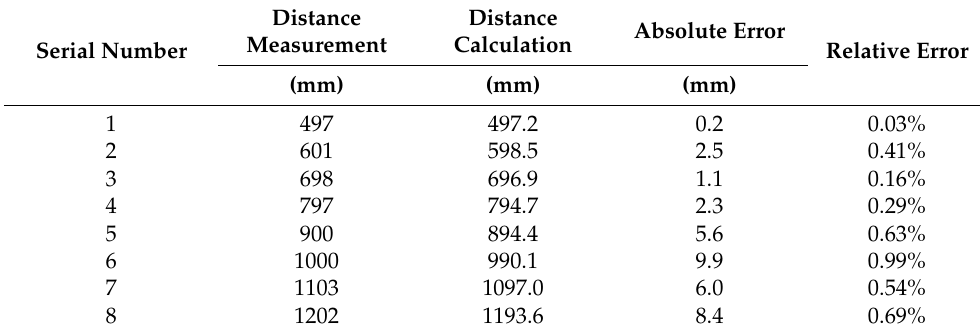
Table 3. Comparison of the results.